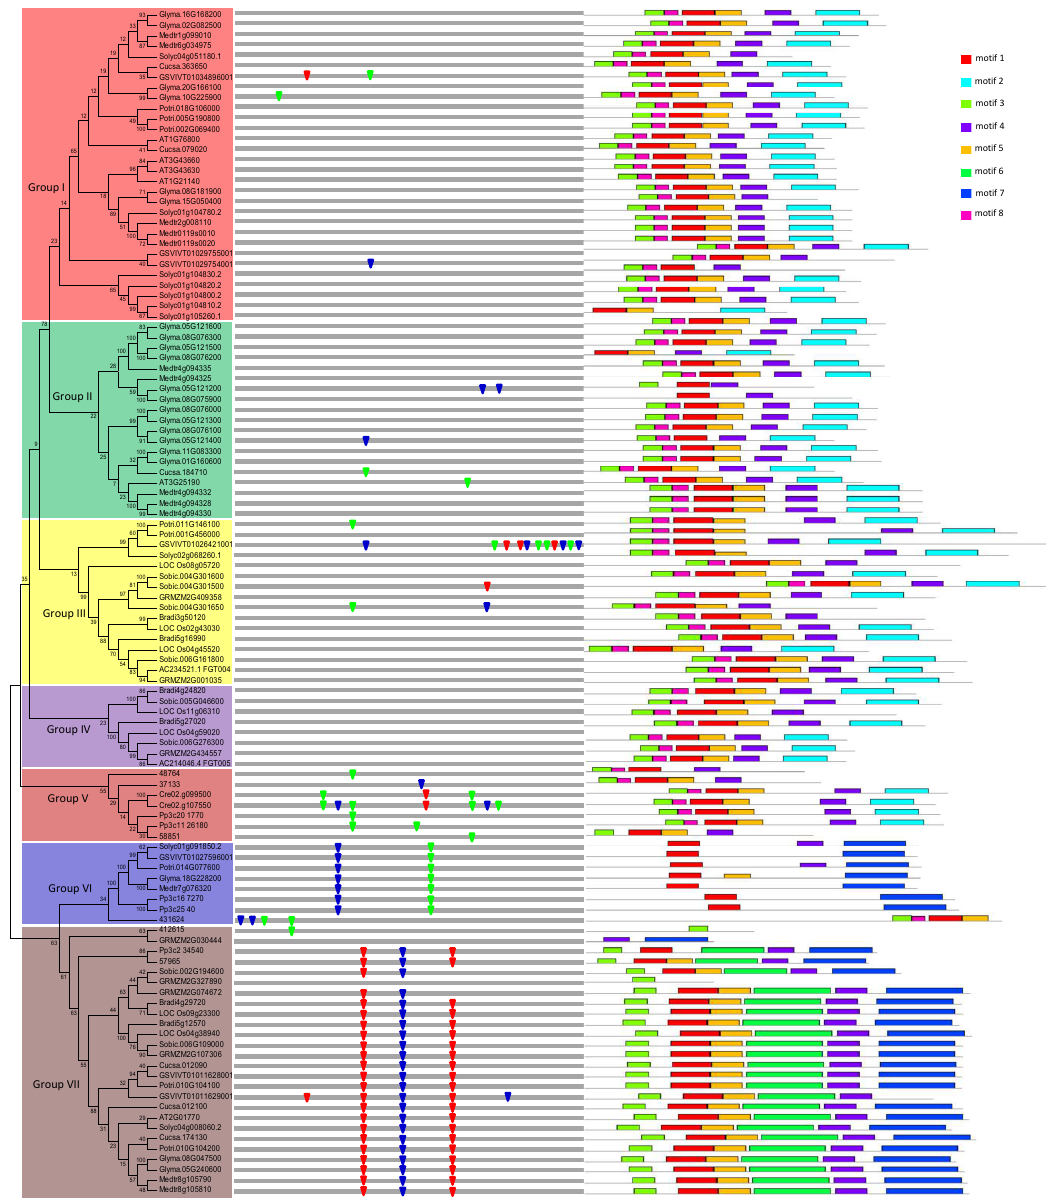
Figure 1. Phylogenetic relationship, gene structure and motif composition of the vacuolar iron transporter ( VIT ) genes in fourteen plant species. The phylogenetic tree is constructed and classified into seven major groups (from Group I to Group VII). The insertion positions of 0, 1, and 2 phase introns are marked with green, blue, and red inverted triangles, respectively. Different motifs of the VIT proteins are displayed by different colored